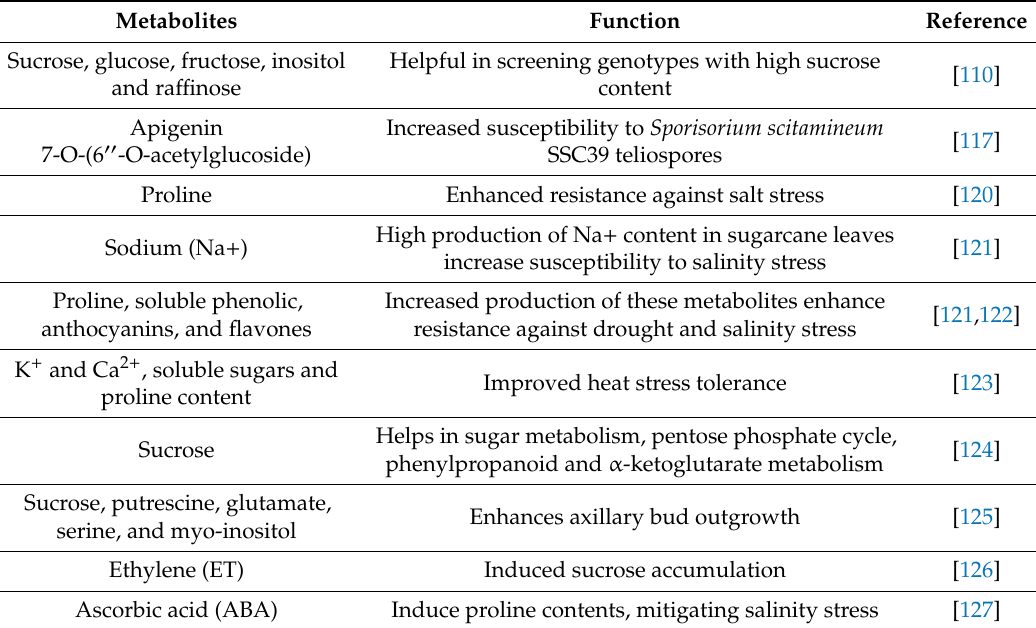
Table 1. Summary of sugarcane metabolites and their role in plant growth and stress